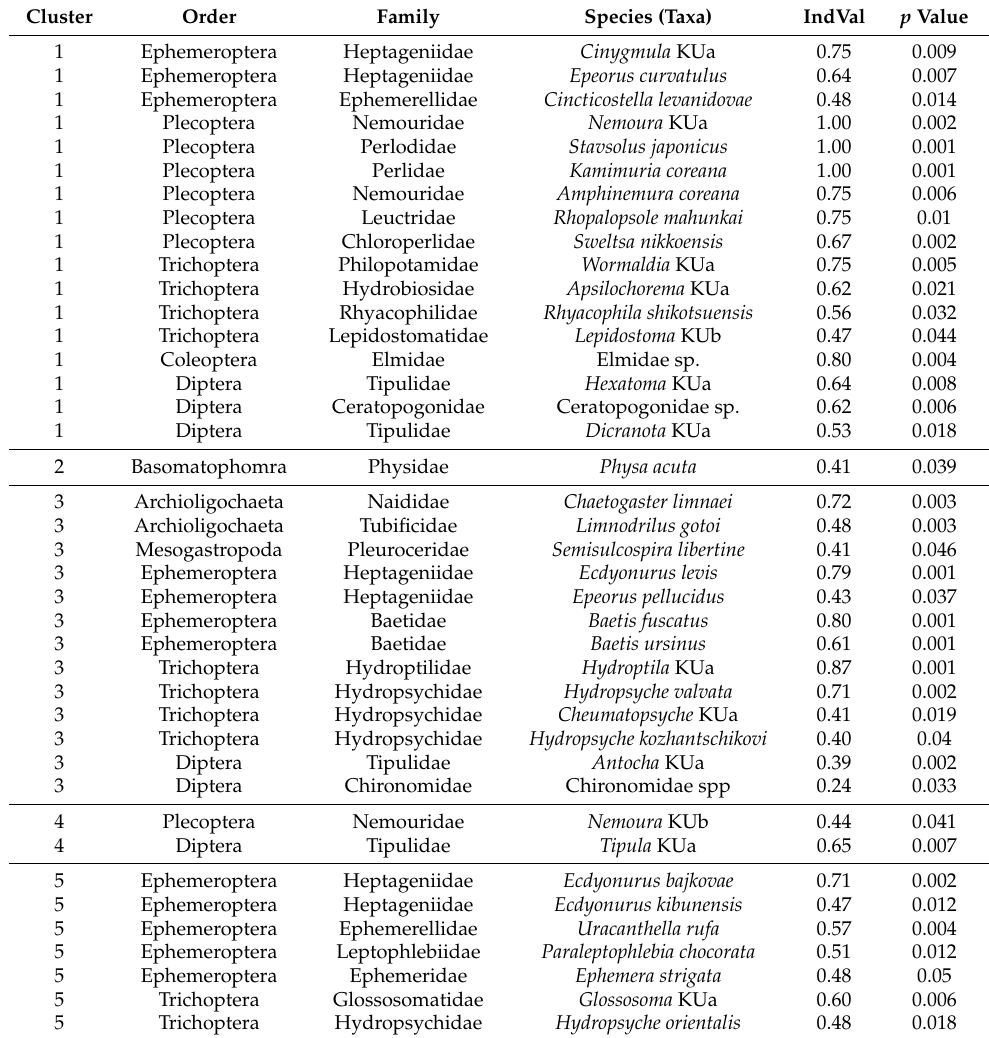
Table 5. Indicator species (or taxa) for five clusters from the self-organizing